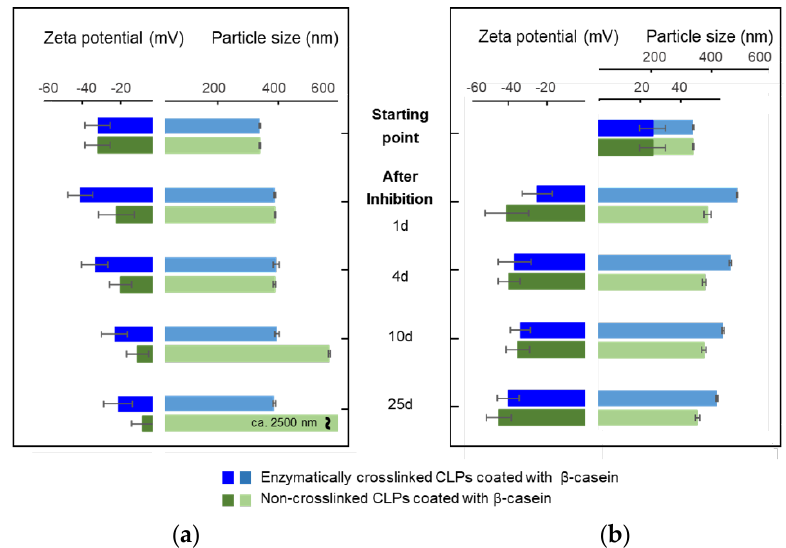
Figure 4. Stability of β-casein coated and enzymatically cross-linked CLPs at ( a ) pH 3.0 and ( b ) pH 7.4 evidenced using average particle size and zeta potential measurements. In both cases, the protein coating following enzymatic cross-linking was performed at 3.0. Enzyme activity was removed using ultracentrifugation following redispersion of the particles at above pH.